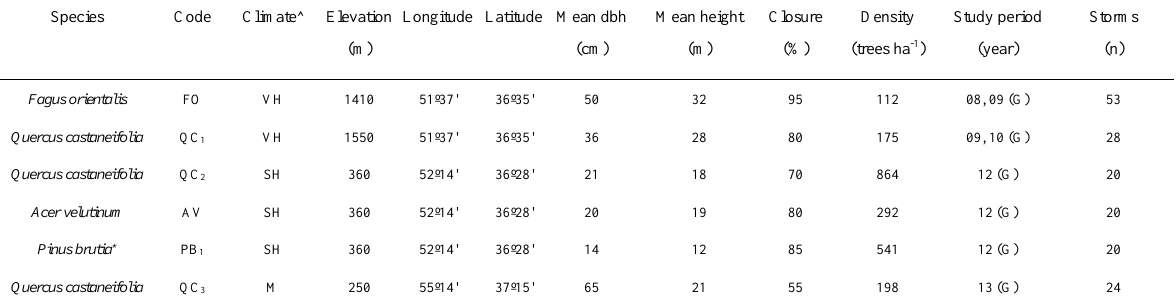
Table 1. Forest sites where throughfall (TF) data were collected, including their climate, geographical coordinates, elevation, and stand characteristics. “G” and “D” refer to growing and dormant seasons, respectively, and dbh refers to diameter at breast height.